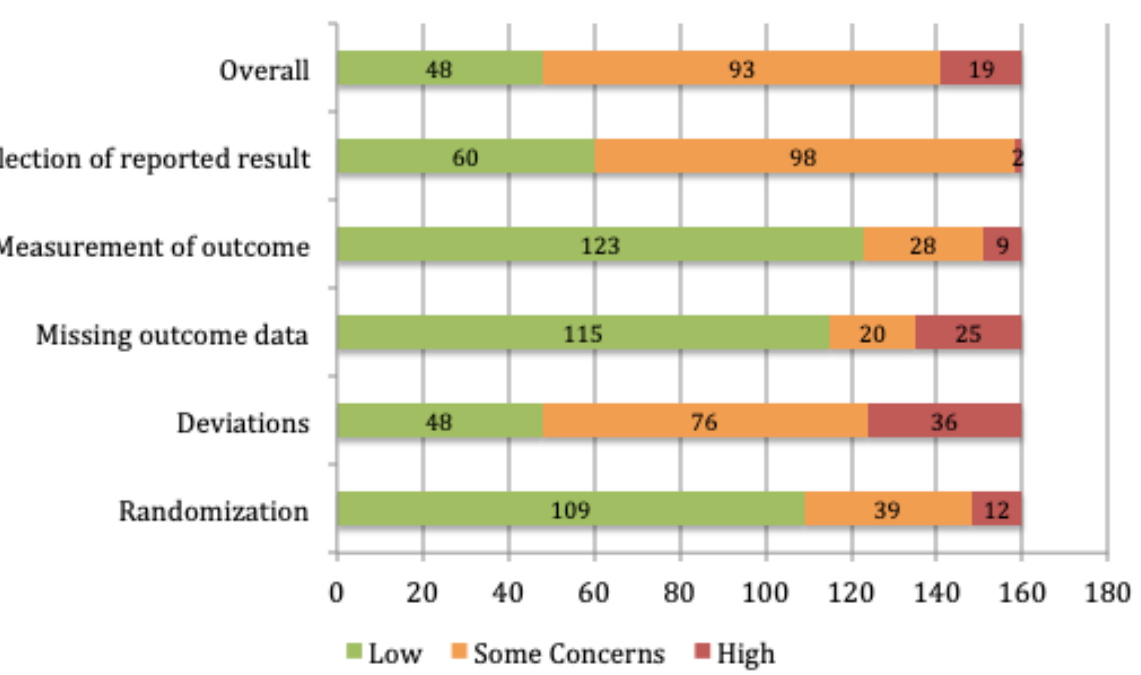
Figure 2. Risk of bias